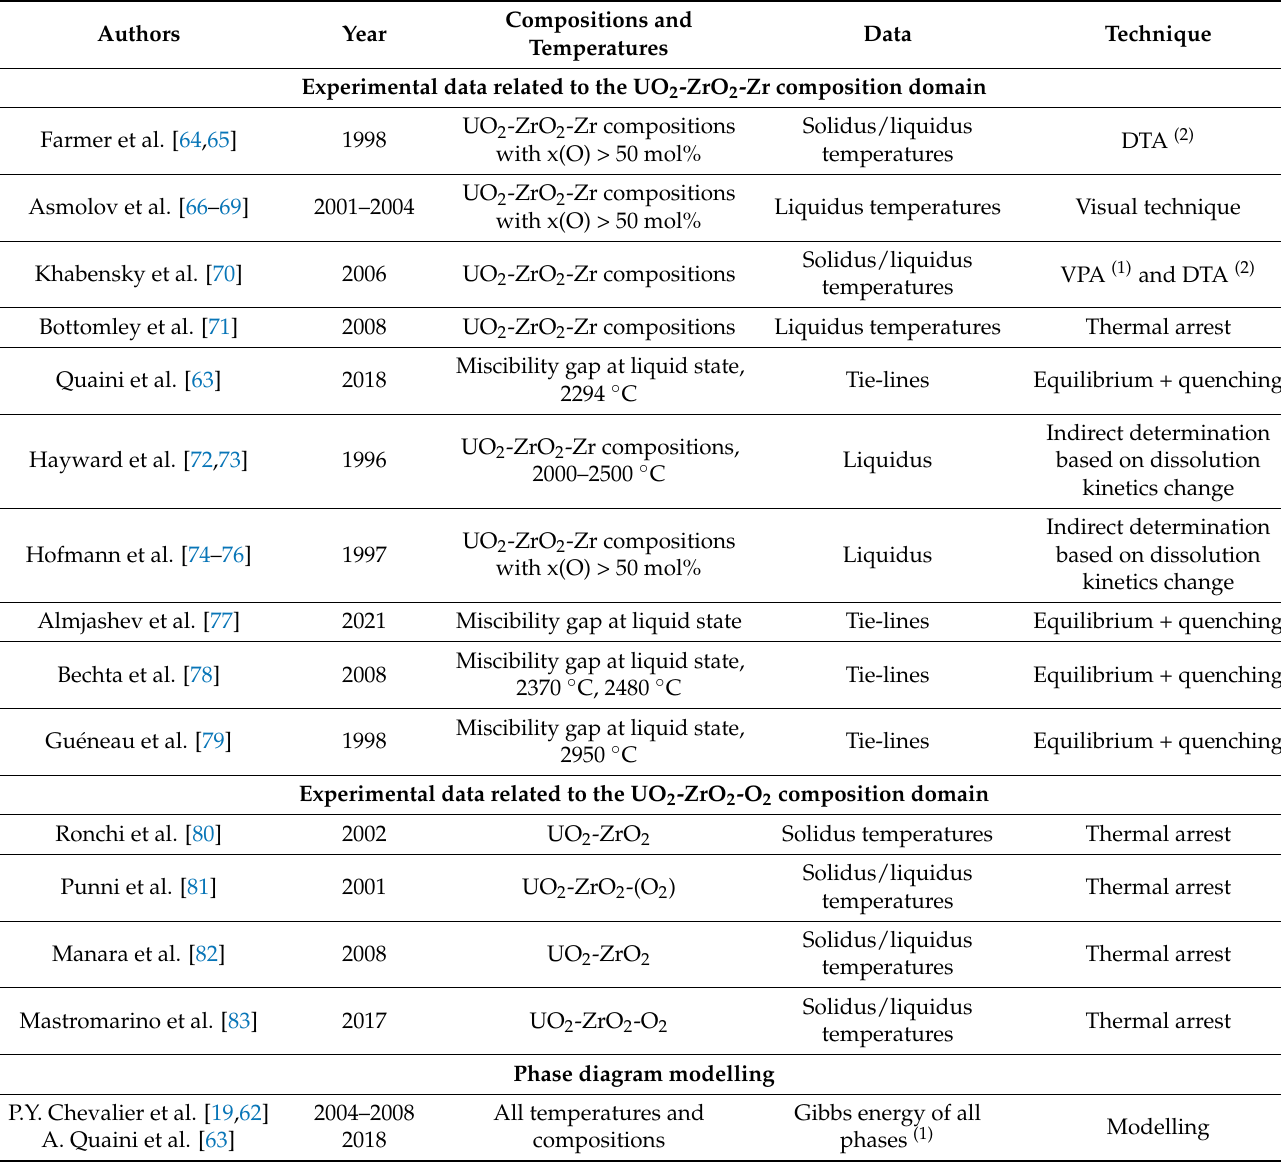
Table 2. More recent thermodynamic data related to the O-U-Zr ternary system at high temperature.